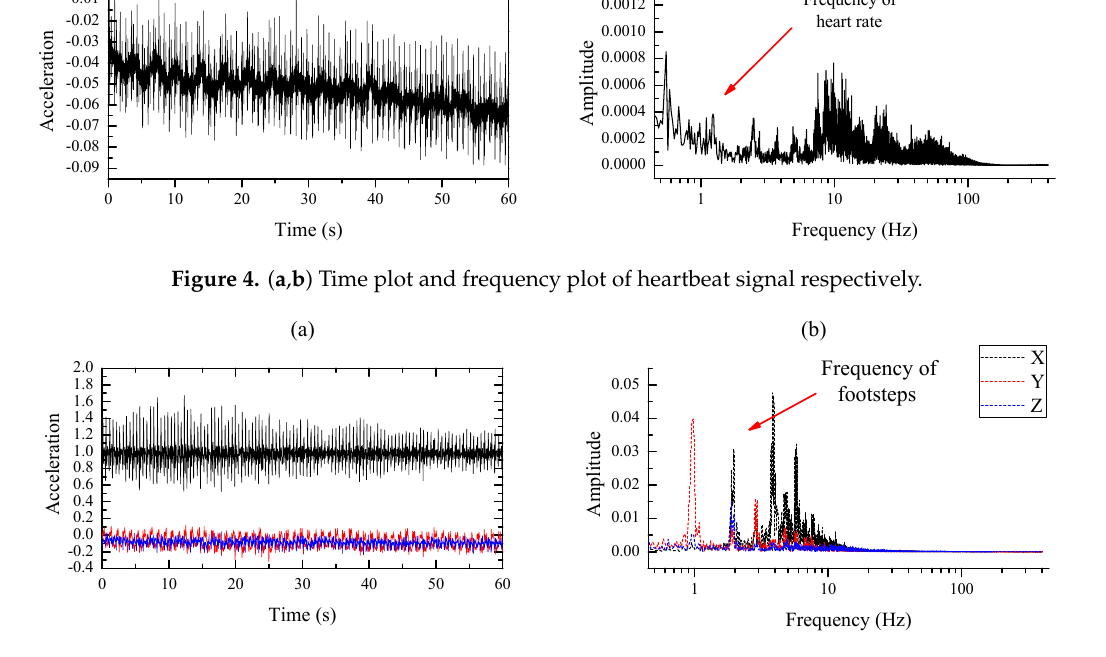
Figure 5. ( a , b ) Time plot and frequency plot of the tri-axis motion signal respectively.